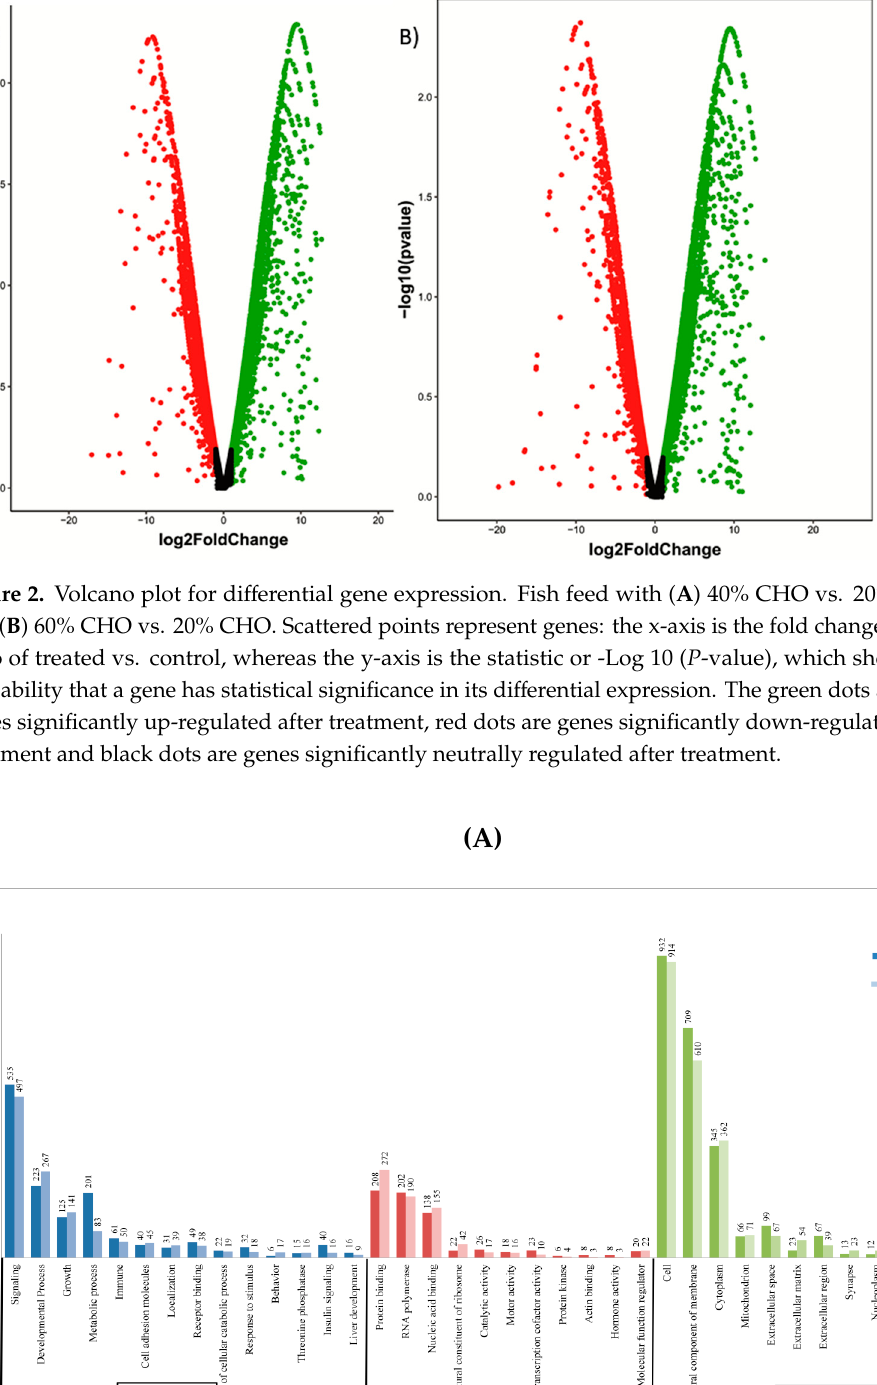
Figure 1. Venn diagram of differentially expressed genes. The sum of numbers in each big circle is the total number of differentially expressed genes in each comparison group, and the overlapping part is the number of common differentially expressed genes among the comparison groups.